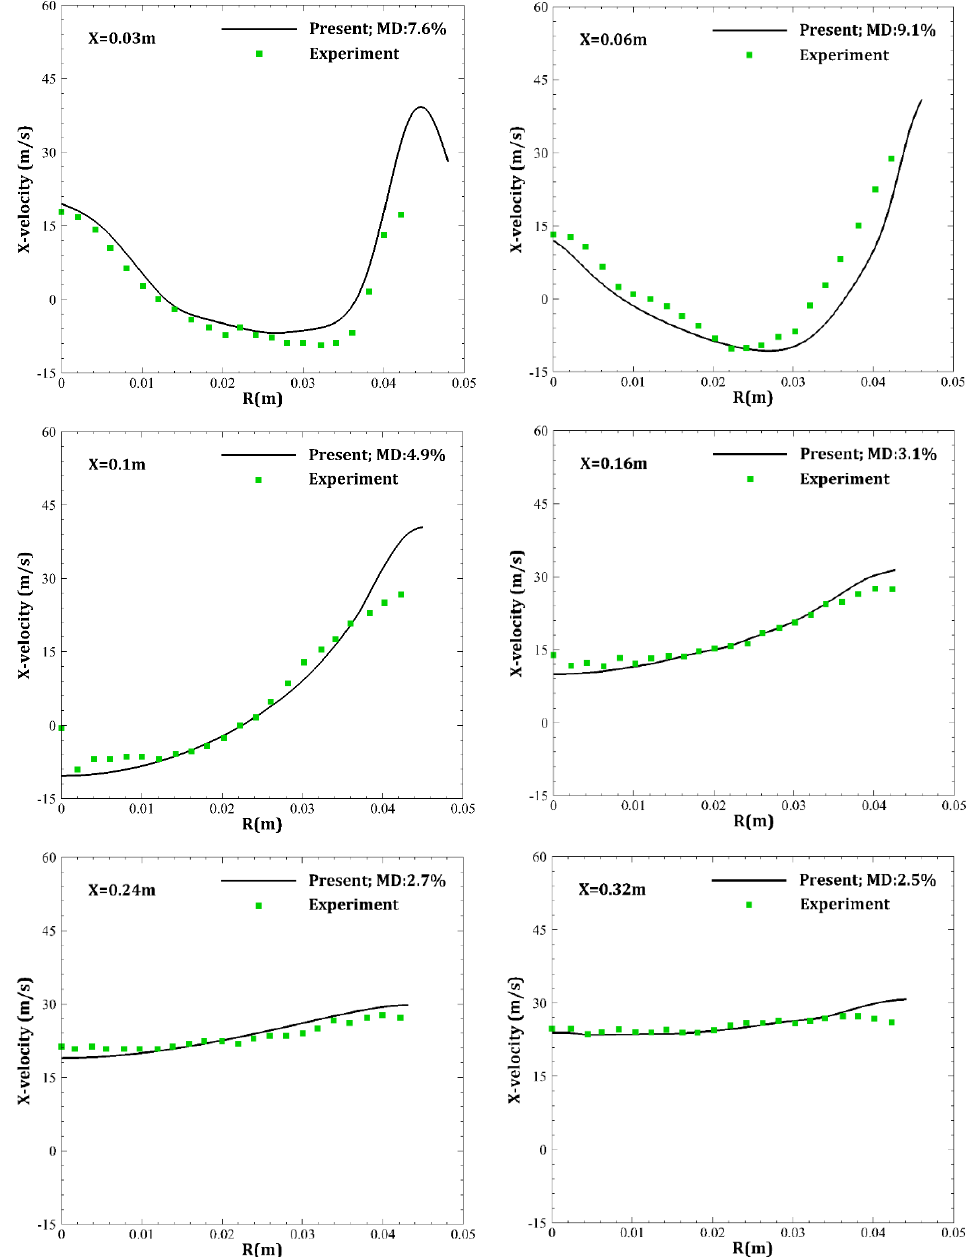
Figure 6. Present lateral profiles of X-velocity as compared with experimental data [1], at different positions.